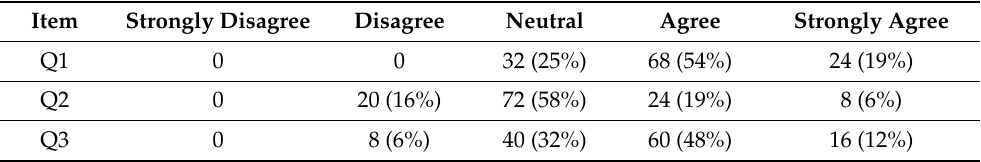
Table 7. Frequency distribution table for items regarding the existence of emotions in